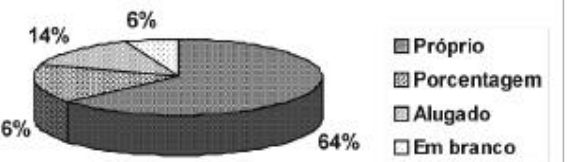
FIGURA 3- Distribuição das Cirurgiãs-dentistas entrevistadas, segundo a condição de trabalho no consultório. Araçatuba,